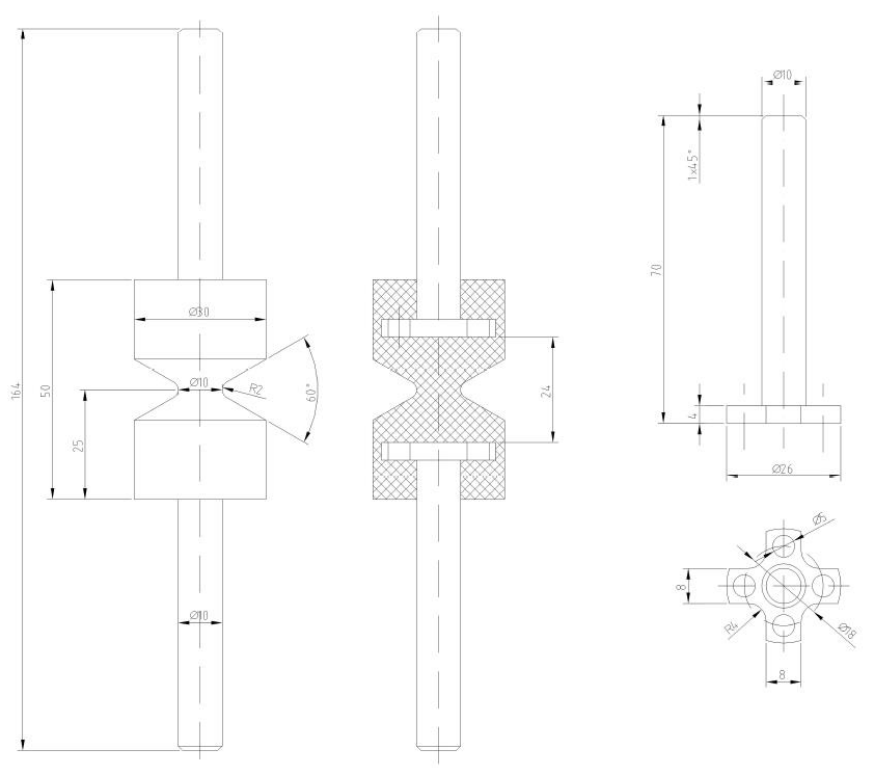
Figure 4. Designed diabolo specimen with metallic fixture for fatigue machine (in mm).